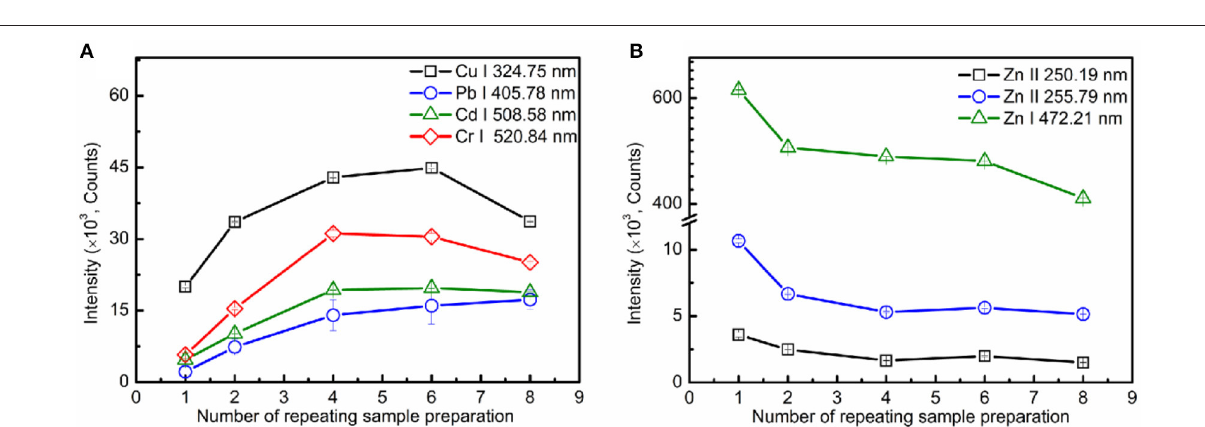
Frontiers in Physics |